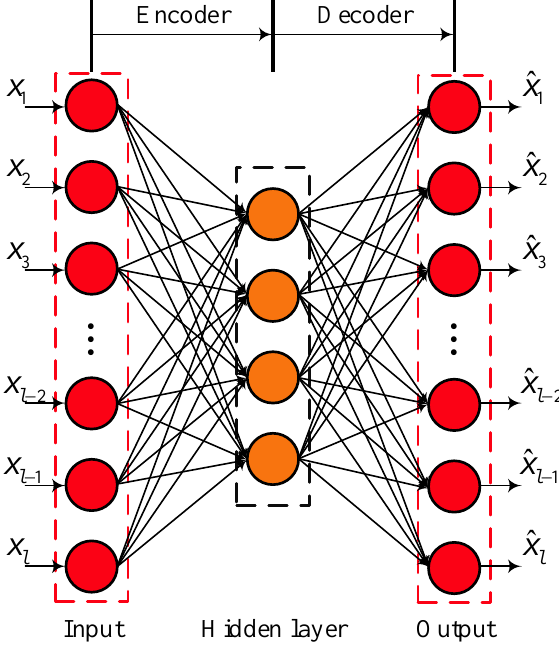
Figure 1. The structure of